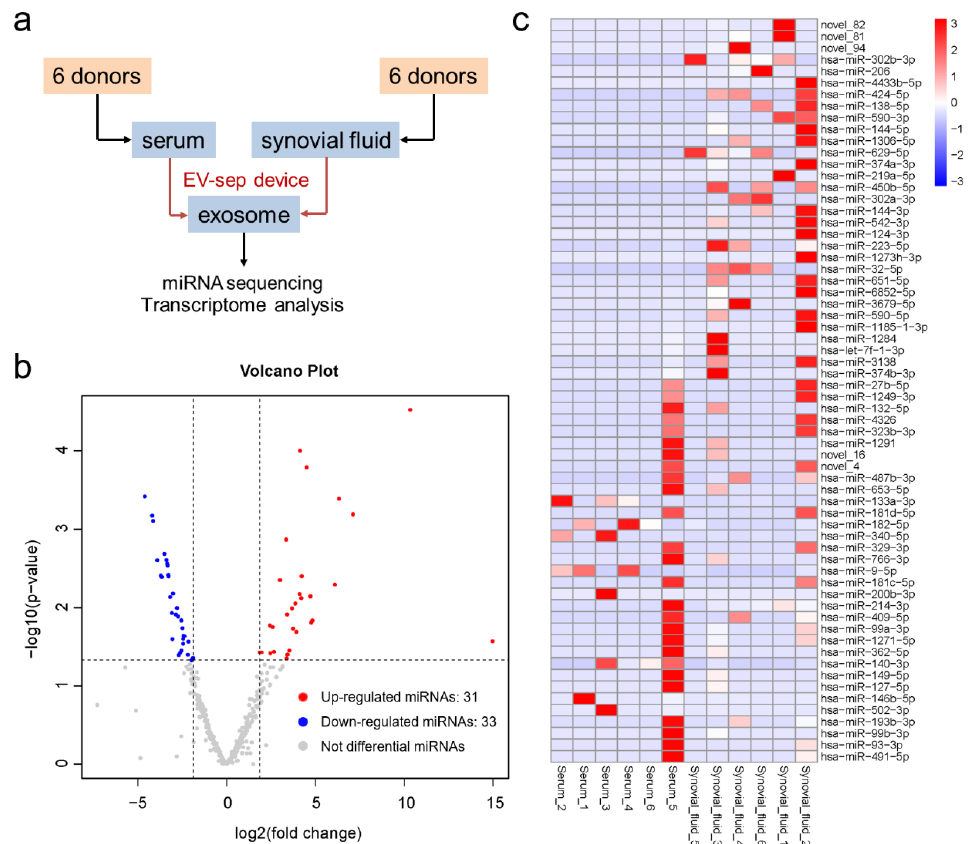
Figure 4. Differentially expressed exosomal miRNAs from the serum and synovial fluid of arthritis patients. ( a ) A general workflow developed for conducting serum and synovial fluid exosome isolation using the exosome separation device, followed by miRNA sequencing and transcriptome analysis. ( b ) Volcano plot of the differentially expressed miRNAs in synovial fluid relative to that in serum. ( c ) Heat map of the differentially expressed miRNAs between the serum and synovial fluid from the arthritis